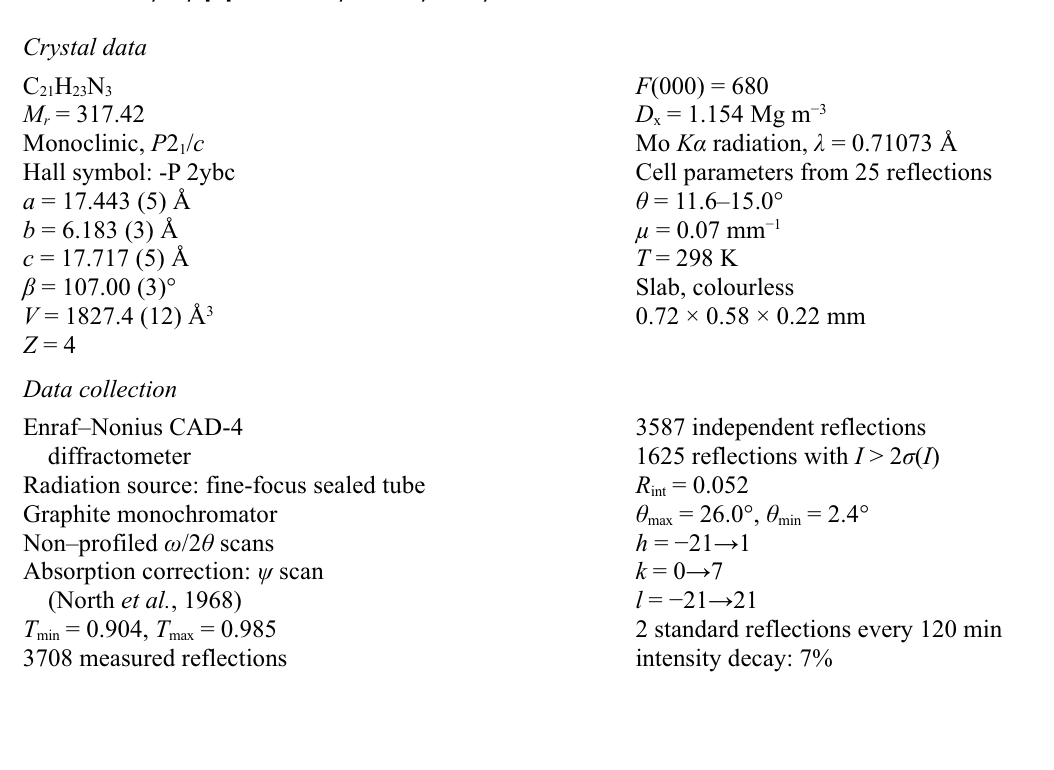
H N . Les ellipsoïdes d'agitation thermique ont 50% de probabilité de présence. 21 23 3